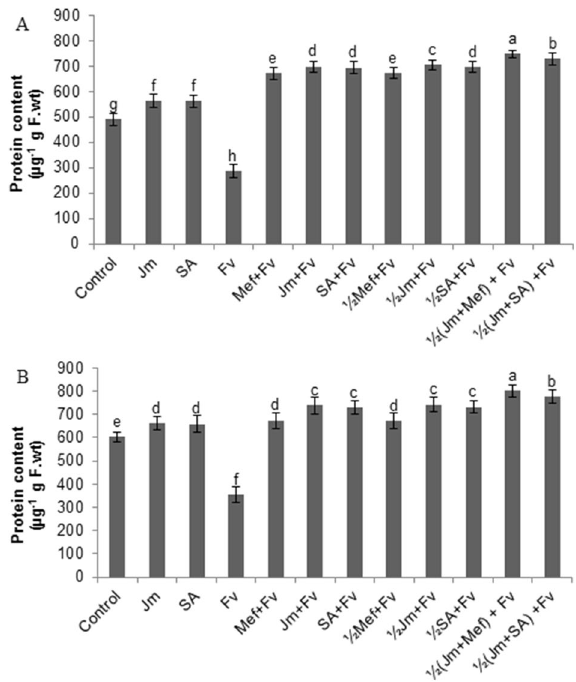
Figure 4. Effect of seed treatments with J. mimosifolia extract and control formulations on total soluble protein content of maize leaves 21 days after inoculation of stems with F. verticillioides . ( A ) Pot experiment, ( B ) Field experiment. Data represent means of 2 years’ pooled experiments for both pot and field experiments. Data are expressed as mean ± standard deviation (SD) of three replicates. Mean values with different letters are significantly different from each other according to the least significant difference ( LSD ) at P < 0.05. See Table 1 for